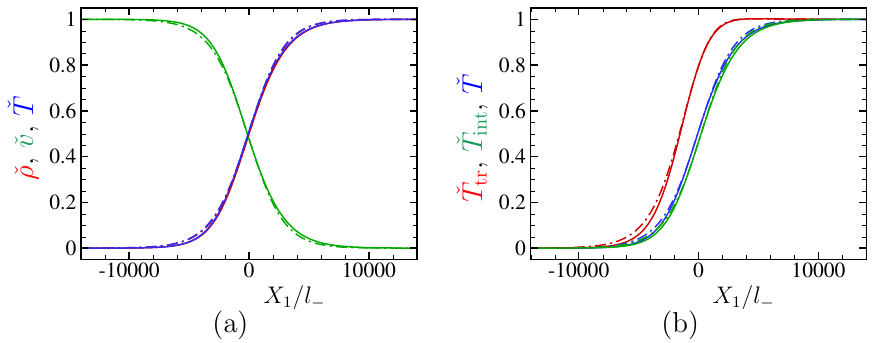
Figure 9. Profiles of ˇ ρ , ˇ v , ˇ T , ˇ T tr , and ˇ T int in the case of SF 6 gas at M − = 1.05. ( a ) ˇ ρ , ˇ v , and ˇ T ; ( b ) ˇ T tr , ˇ T ˇ T . See the caption of Figure 2. int , and